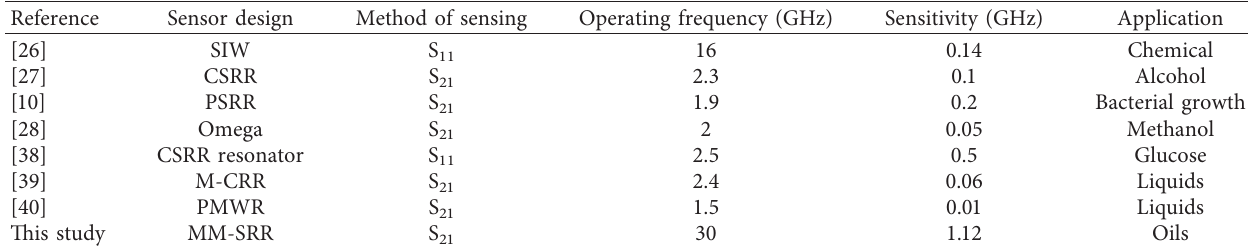
Table 3: Comparison with the other designed